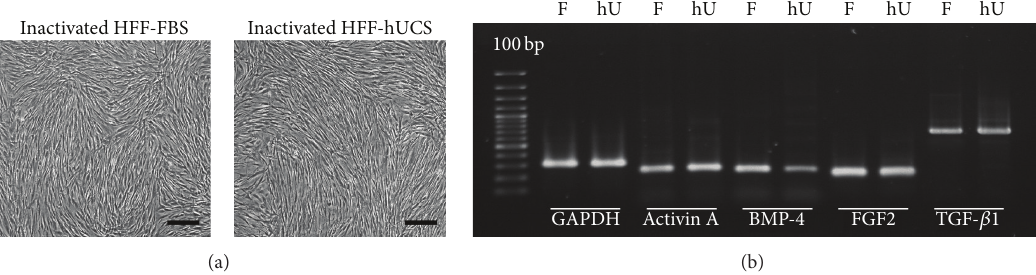
Figure 3: Morphology and gene expression of inactivated human foreskin fibroblasts prior to use as the feeder layer. HFF-hUCS and HFF- FBS survived inactivation through mitomycin-C treatment and maintained typical fibroblast-like features (a). RT-PCR was performed for the detection of supportive feeder cell-related genes. Inactivated HFF-hUCS and inactivated HFF-FBS expressed Activin A, FGF2, TGF- 𝛽 1, and BMP-4. GAPDH was used as the house keeping gene (b). BMP = bone morphogenetic protein, FGF = fibroblast growth factors, TGF = transforming growth factor, HFF = human foreskin fibroblasts, F and FBS = fetal bovine serum, hU and hUCS = human cord blood-derived serum, RT-PCR = reverse transcription polymerase chain reaction, and GAPDH = glyceraldehyde 3-phosphate dehydrogenase. Scale bars = 200 𝜇